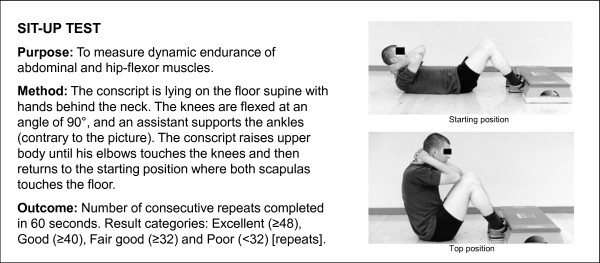
Description of sit-up test. The test is based on practice in the Finnish Defence Forces.